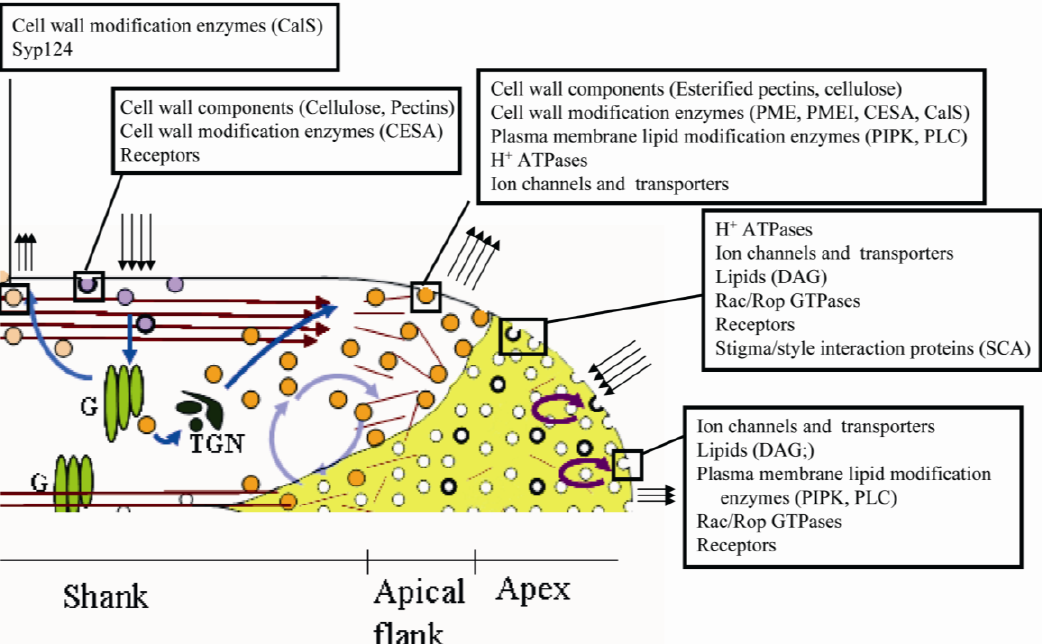
Figure 2. Exocytosis and endocytosis are key processes for pollen tube growth. Pectins, cellulose and callose are differently distributed and modified, allowing cell wall to be expandable in the tip, so supporting rapid extention. Pectin de-esterification and cellulose deposition in the shank allow firm pollen tube shape during its growth through the style. Recycling processes occurring in the apex and shank of the pollen tube are involved in maintaining membrane domains. The specific protein/lipids composition of the plasma membrane has an important role in controlling cytoskeleton, vesicles flow and fusion, signal transduction and ion gradients in the apex of the pollen tube; these are all essential for polar growth. Exocytic and endocytic pathways contribute to maintaining this distribution over time in elongating pollen